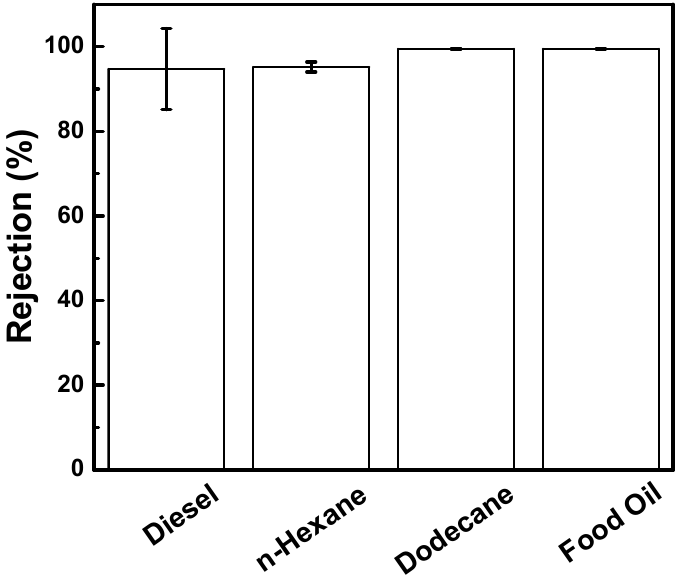
Figure 7. Rejection of CA O-MMT membrane for different oil–water emulsion.